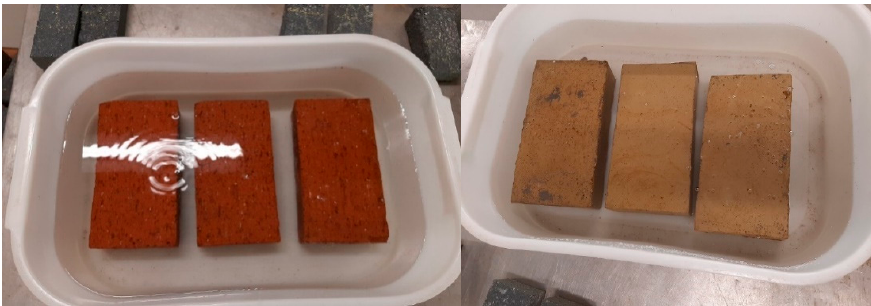
Figure 5. The wetting and drying cycle durability test setup for the clay and PW bricks. The concentration of the H 2 SO 4 was adjusted using water at different ratios, the water was placed in a bath while the acid was gradually poured into the bath until the concen- tration of the acid attenuated to the desired concentrations. This exercised was performed at a controlled temperature of 18 °C due to the exothermic reaction of the H 2 SO 4 . Subse- quentially, the bricks were immersed in the acid. However, the concentration of acid so- lutions with their corresponding pH values is presented in Table 1.